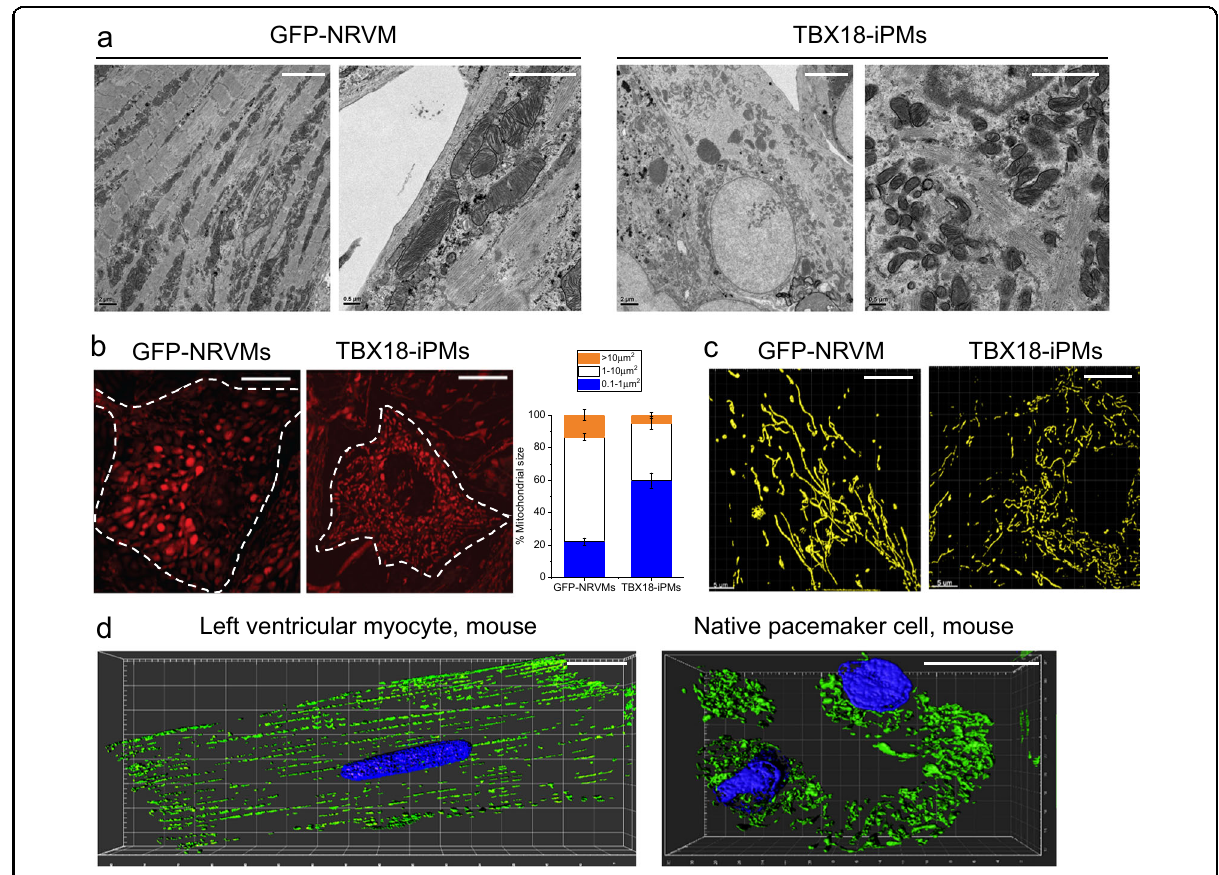
Fig. 2 Smaller mitochondria in TBX18-iPMs and native pacemaker cells. a Representative EM images of mitochondria with two different magni fi cations from GFP-NRVMs and TBX18-iPMs. b Mitochondria size distribution of GFP-NRVMs and TBX18-iPMs. Representative images of MitoTracker staining (left) and percentage of mitochondria according to their size distribution in three groups: >10 .m 2 , 1 – 10 µm 2 , and 0.1 – 1 µm 2 (right) ( n = 10 for GFP-NRVMs and n = 14 for TBX18-iPMs). c Representative superresolution images of mitochondria stained with MitoTracker from GFP-NRVMs and TBX18-iPMs. d Representative superresolution images of mitochondria stained with MitoTracker from freshly isolated mouse ventricular myocytes and pacemaker cells. Scale bar: 2 µm (a: right panels of each group), 5 μ m ( a : left panels of each group and b ), and 10 μ m ( c and d ) * p <